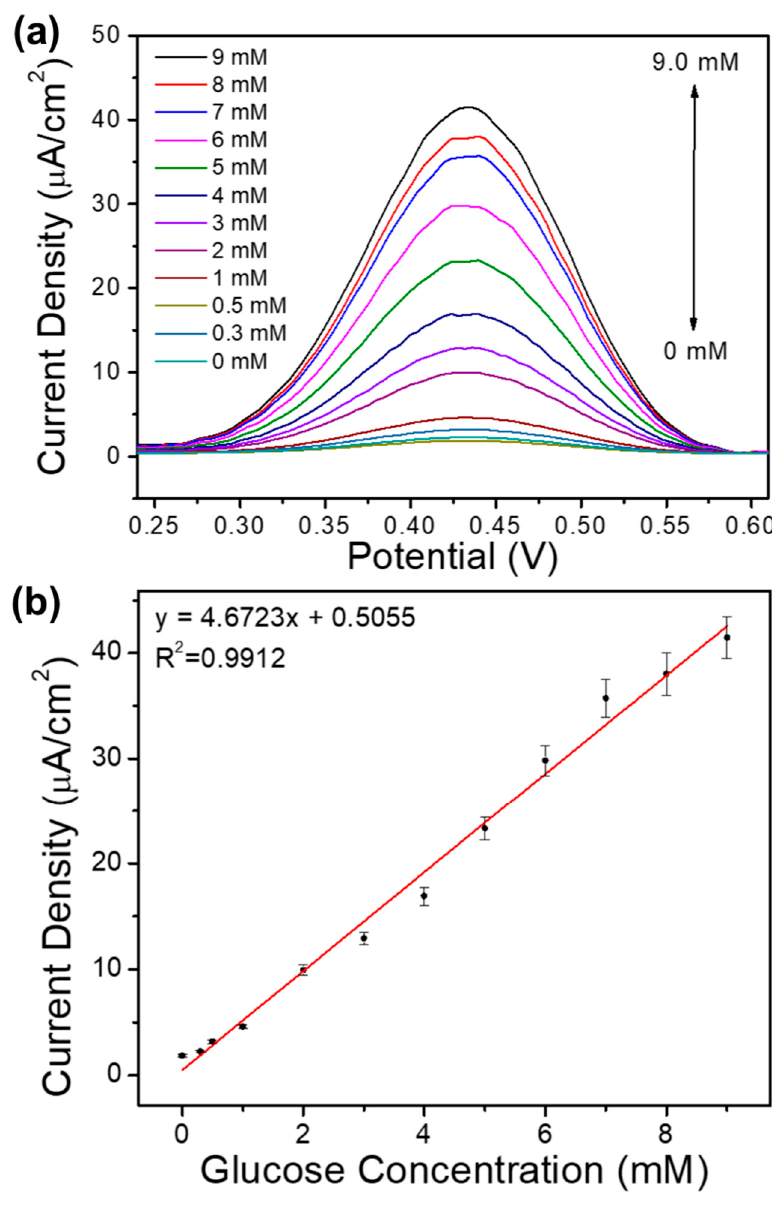
Figure 8. ( a ) DPV measurement of glucose in 0.1 M of PBS pH 7.4 with the variation concentration of (0.0–9.0 mM); ( b ) Linear regression plots between current density and variation in glucose concentration.